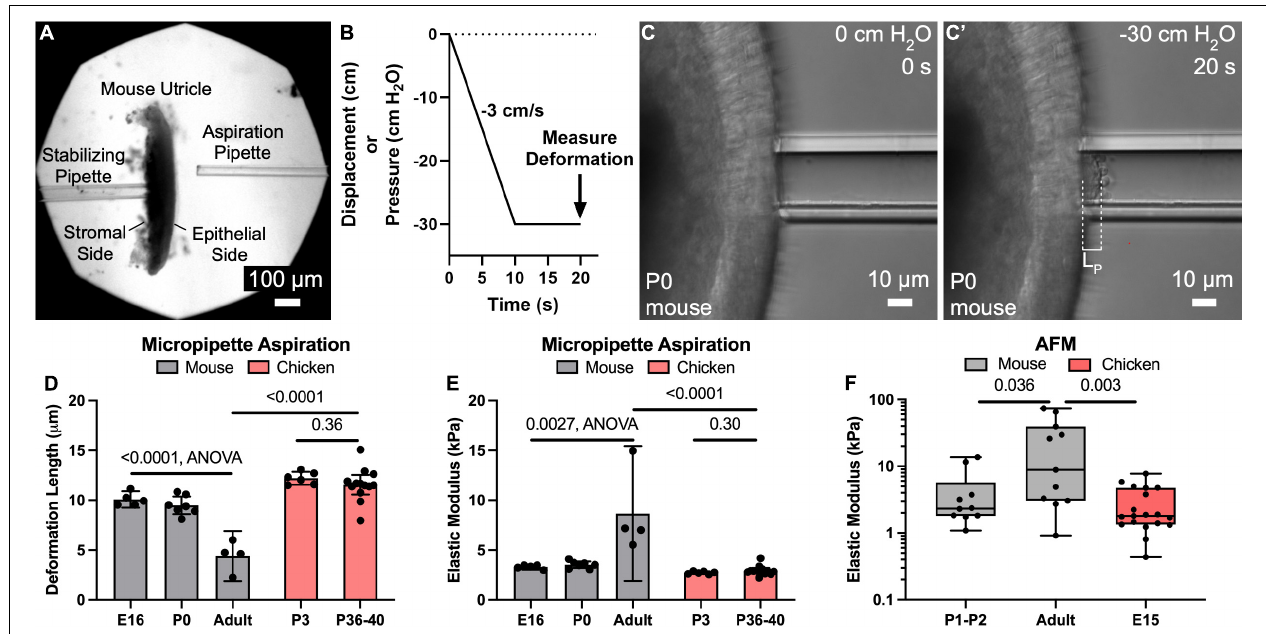
FIGURE 1 | Micropipette aspiration and AFM measurements reveal that the apical surface of utricles from mature mice are significantly more resistant to deformation than those of newborn mice and chickens. (A) Low magnification image of a mouse utricle prior to micropipette aspiration. A stabilizing pipette ∼ 50–100 µ m in diameter (left) was used to apply light suction on the “stromal side” to maintain the utricle in place. Another pipette 22.5 µ m ( ∼ 5 cell apices) in diameter (right) was used to apply a defined negative pressure to the epithelial surface of the utricle. (B) The negative pressure was ramped from 0 cm H 2 O to –30 cm H 2 O over a span of 10 s, and then maintained at –30 cm H 2 O for an additional 10 s. The deformation length of the apical surface was after the full 20 s “pull” was recorded. (C,C’) High magnification images of the apical surface of a P0 mouse utricle during application of negative pressure, producing a deformation of length L P . (D) Plot of mean deformation length of utricles from mice and chickens of various ages. Error bars denote 95% confidence intervals. Dots represent an average of at least three measurements from a single utricle. P -values are listed from unpaired t -tests or ANOVA. (E) Plot of elastic moduli as measured by micropipette aspiration of the utricular epithelial surface, as calculated from the deformation lengths in (D) . Error bars denote 95% confidence intervals, and each dot represents one utricle. P -values are listed from unpaired t -tests or ANOVA. (F) Boxplot in logarithmic scale of elastic moduli as measured by AFM of the utricular epithelial surface. Each dot represents the average elastic modulus obtained from an eight-point line scan. P -values are indicated from Mann-Whitney